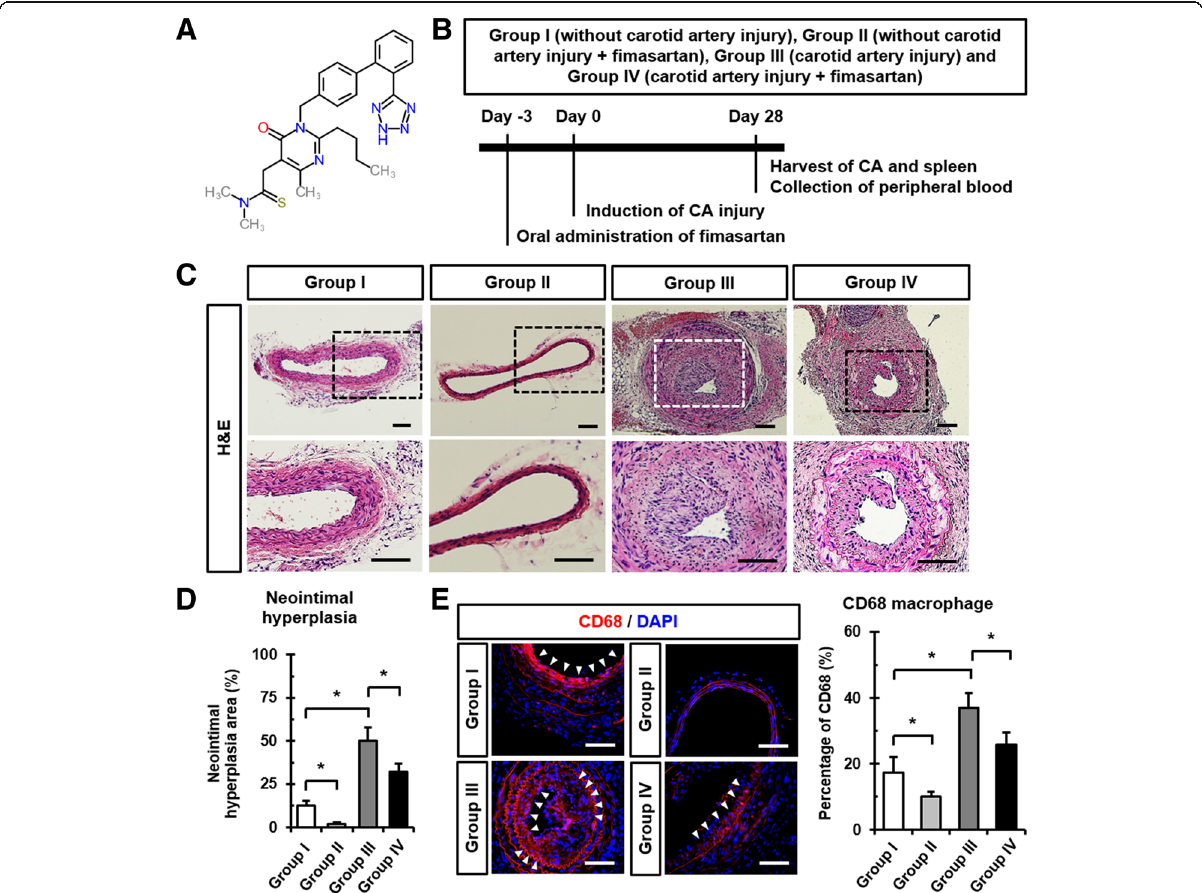
Fig. 1 Regression of CA injury-induced neointimal hyperplasia in ApoE KO mice by Fimasartan administration. a Chemical structure of fimasartan (2-n-butyl-5-dimethylamino-thiocarbonyl-methyl-6-methyl-3-{[2-(1H-tetrazole-5-yl)biphenyl-4-yl]methyl}pyrimidin-4(3H)-one). b Schematic depiction of the study protocol. c Representative H&E-stained images of the CA cross sections of ApoE KO mice. Boxed regions were magnified in the under panels. Scale bar: 100 μ m. d Quantitative analysis of the incidence of neointimal hyperplasia areas in CA after CA injury and/or fimasartan administration. Data shown represent mean±SD on 40 sections (two fields per section, two sections per CA, n =10 for each group). * p <0.05. e Representative immunofluorescence images and quantitative analysis results showing CD68 + macrophage (red) expression in CA at 28days after CA injury and/or fimasartan administration. White arrows indicate CD68 + macrophages in CA. Nuclei were stained with DAPI. Scale bar: 100 μ m. * p <0.05. All experimental data are from n =10 of ApoE KO mice in each